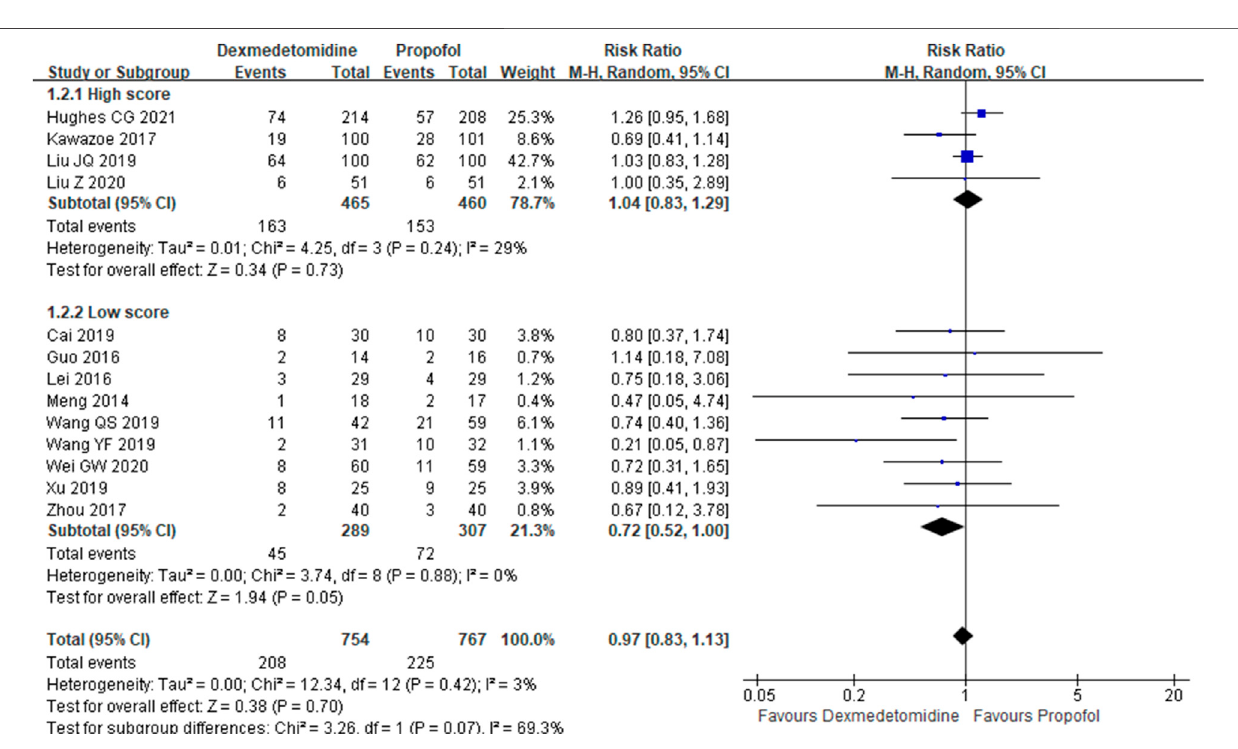
Frontiers in Pharmacology |